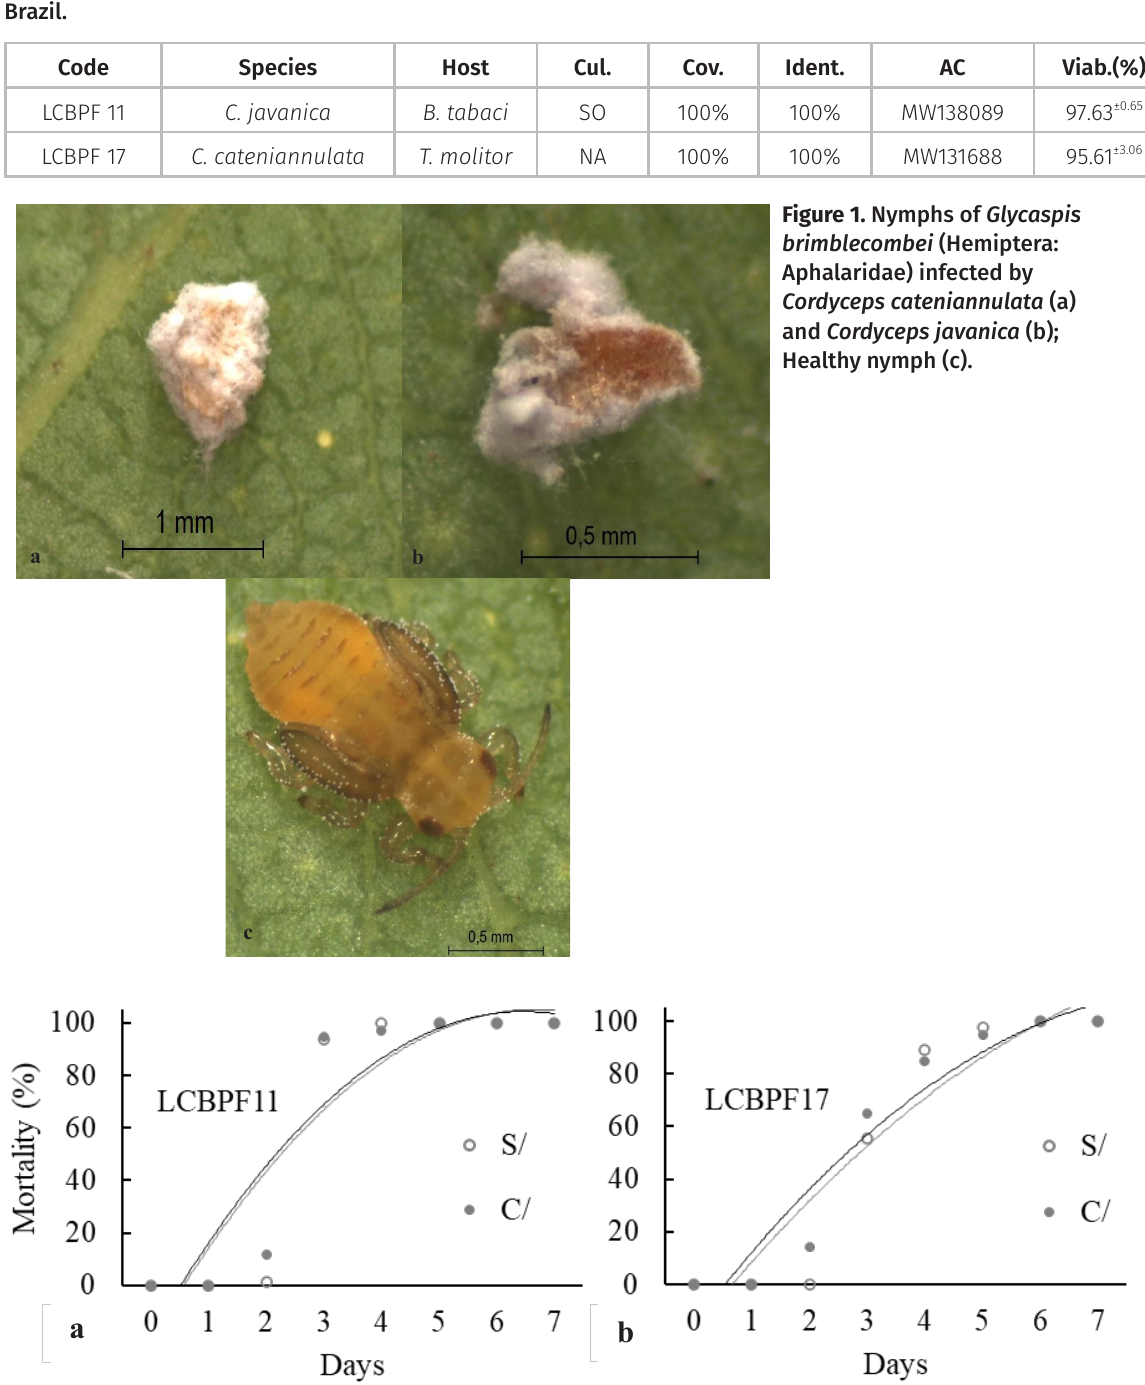
Figure 2. Accumulated corrected mortality of Glycaspis brimblecombei (Hemiptera: Aphalaridae) nymphs with (C/) or without (S/) lerp, over the days after application of the LCBPF 11 Cordyceps javanica (a) and LCBPF 17 Cordyceps cateniannulata (b) isolates with